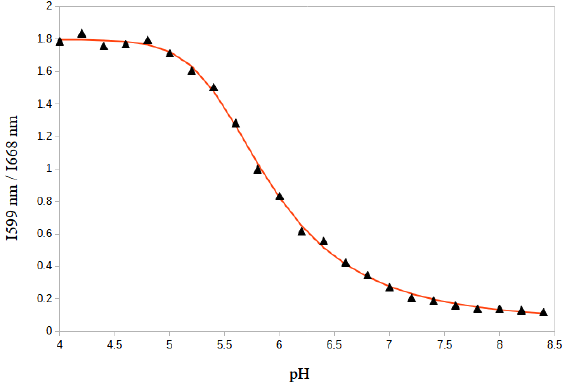
Figure 3. Fluorescence images of SNARF-4F in DMEM medium from pH 4.0 (left) to pH 8.00 (right) under 514 nm excitation. For each pH, we present the average emission spectrum over the entire image (2048 × 2048 pixels).